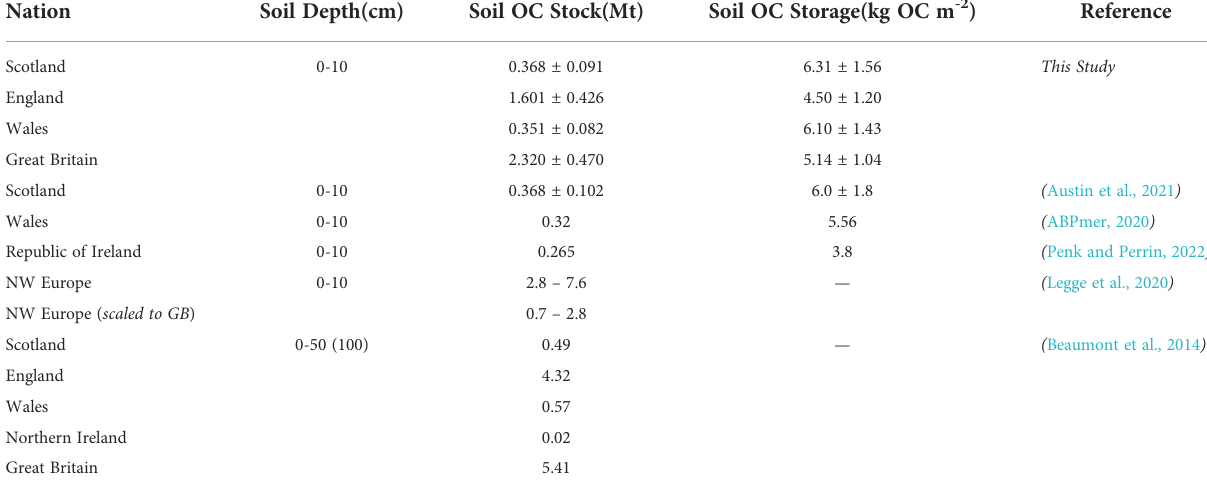
TABLE 3 Saltmarsh sur fi cial soil OC stock estimates from this study in comparison to existing OC soil stocks from Great British and temperate saltmarsh systems. Note that Beaumont et al. (2014) estimates are for depths 0 - 50 or 0 - 100 cm. Nation